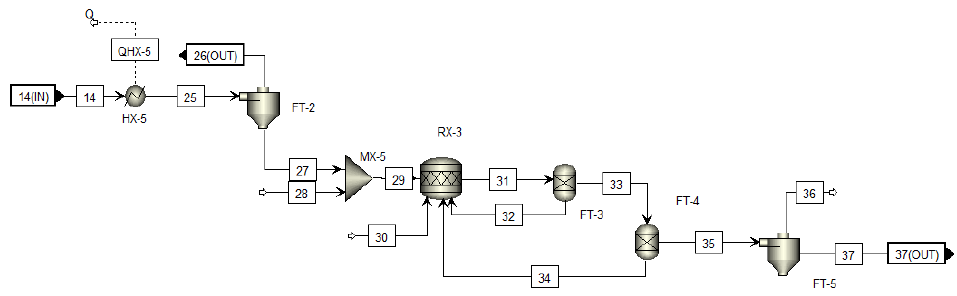
Figure 3. Hydrolysis stage flowsheet in topology 1.